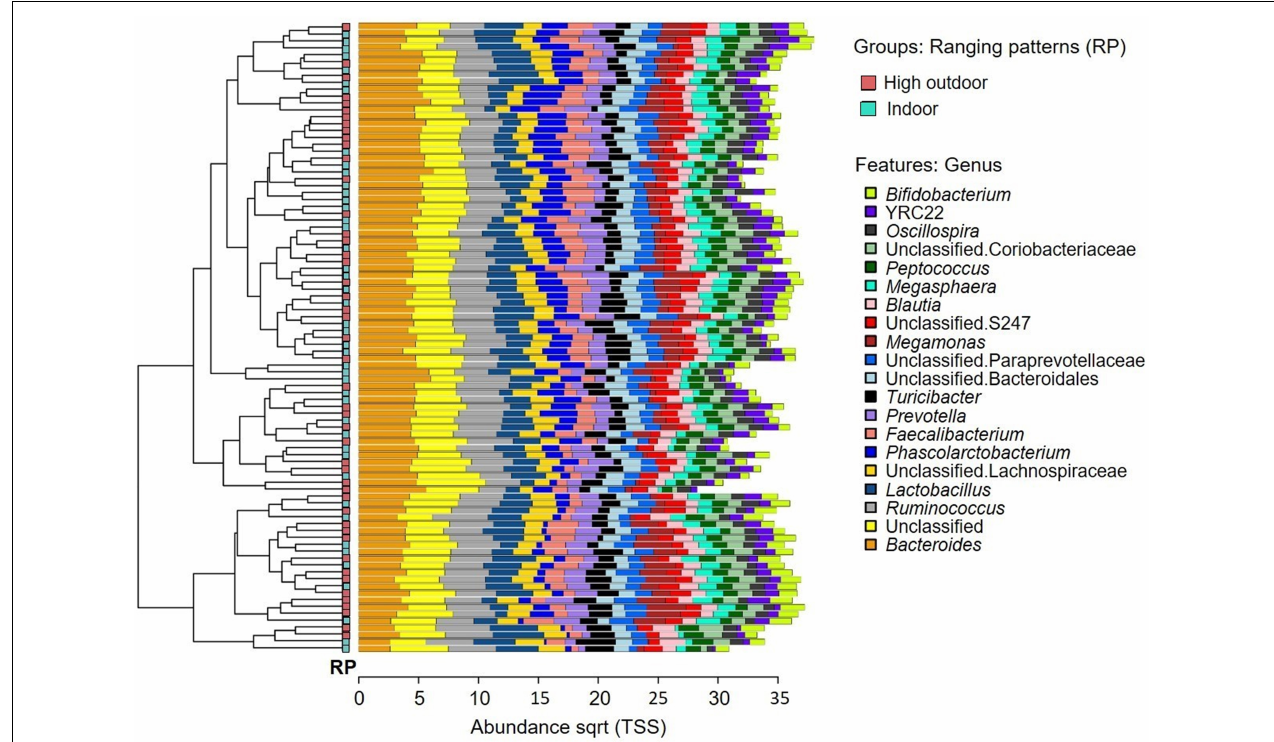
FIGURE 5 | Microbial community composition of free-range hens at 65 weeks of age from different ranging patterns (high outdoor, indoor). Clustered bar chart showing 20 most abundant genera.